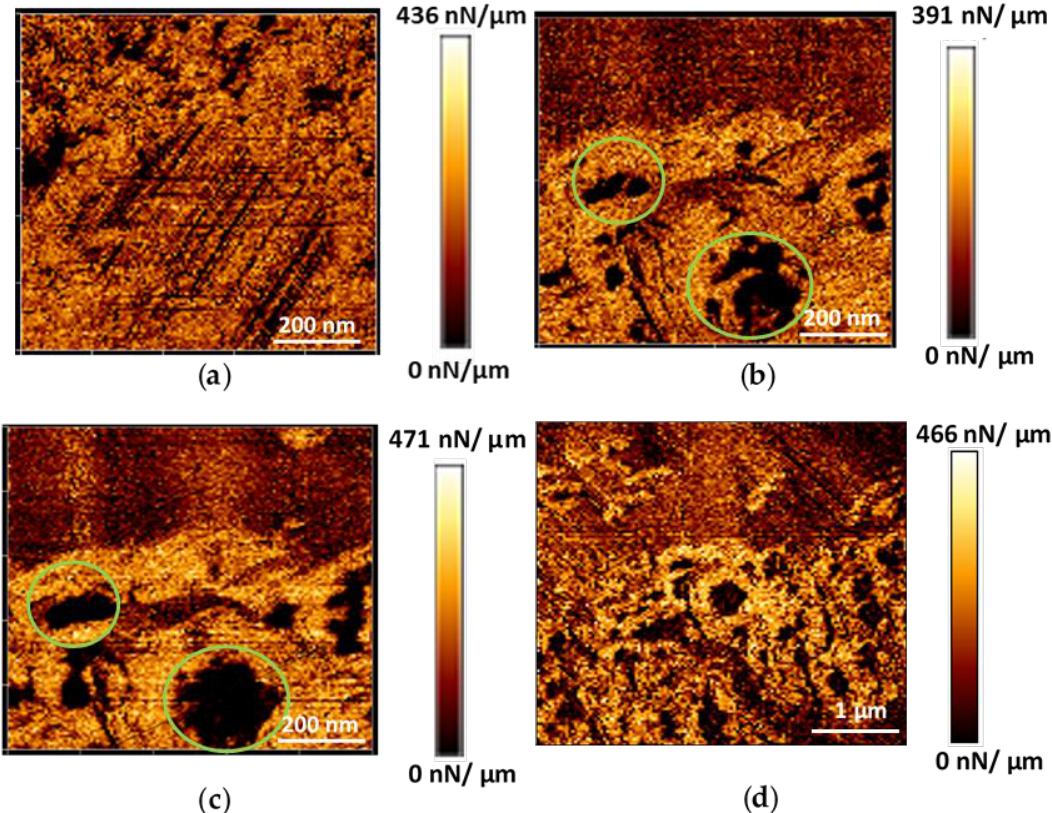
Figure 5. AFM images (stiffness map) (128 pixels × 128 pixels), of a microMOF ( − ) crystal in water at time 0 ( a ), in PBS pH = 7.4 at time 0 ( b ) and after 2 h at different magnifications ( c , d ). Defects that are progressively enlarging during degradation are surrounded with green circles.